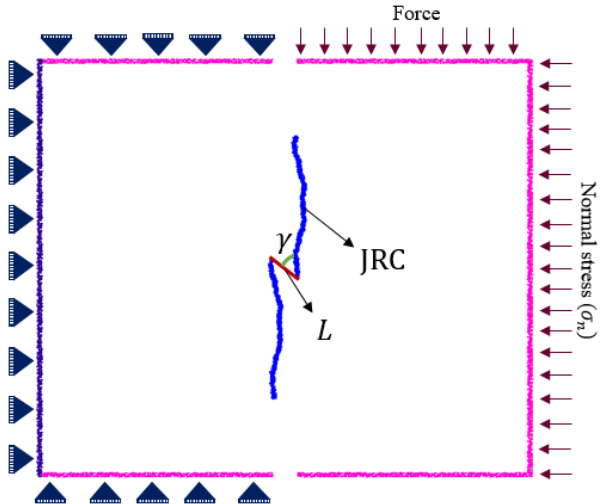
Figure 4. Pre-cracked direct shear specimen illustrating the studied parameters γ , L, σ n , and JRC.